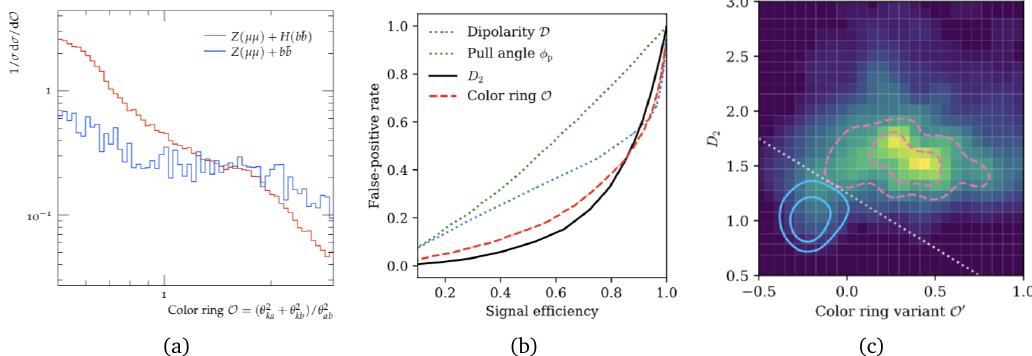
Figure 2: Fig.2a shows the Z( µµ )H( b ¯ b ) vs. Z( µµ ) b ¯ b distributions for the colour ring observable. Fig.2b shows the ROC curves for the four observables considered in this study. Fig.2c illustrates the complementarity of D with the colour ring in a 2D 2 distribution,with contour overlays at 50% and 75% of the maximum values for signal (solid) and background (dashed) densities separately. Figure reproduced from [ 1 ] , used under CC-BY license.